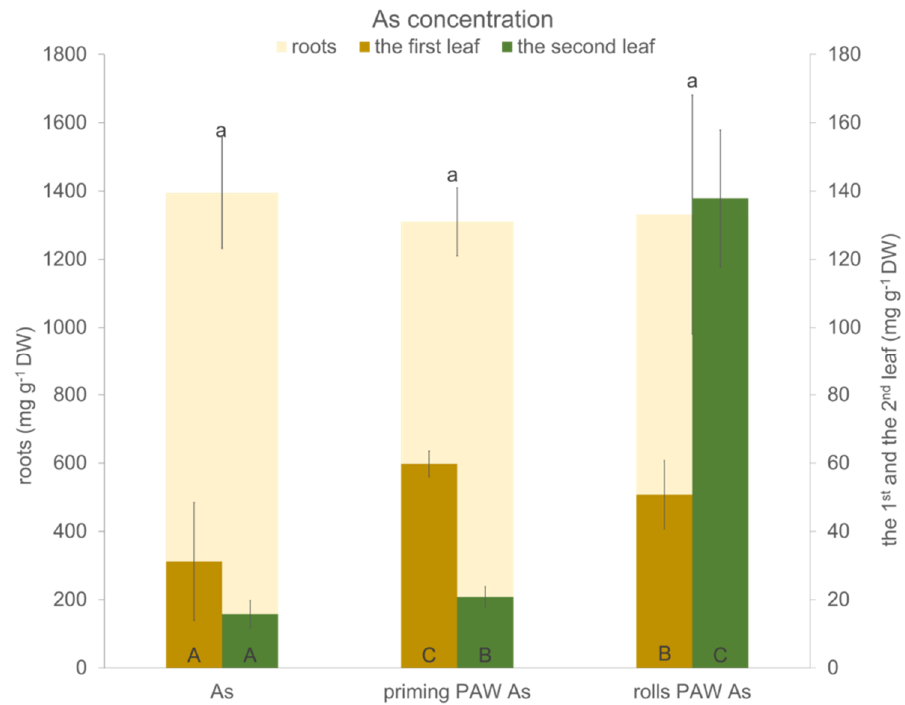
Figure 10. The As concentration per dry weight of the roots, the first leaf, and the second leaf (hybrid Bielik) after 10 days of hydroponic cultivation as As treatment or As treatments pre-treated with PAW (priming PAW As and rolls PAW As treatments).